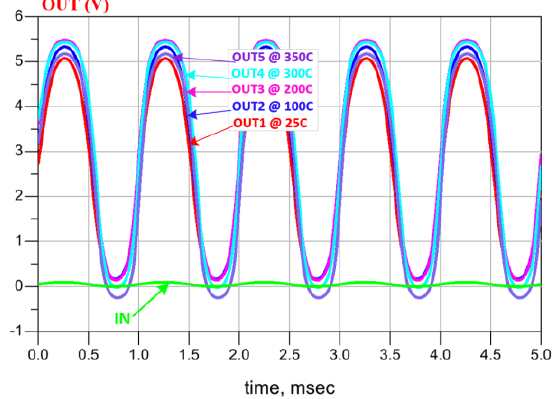
Figure 8. Amplifier simulated results at different temperatures.